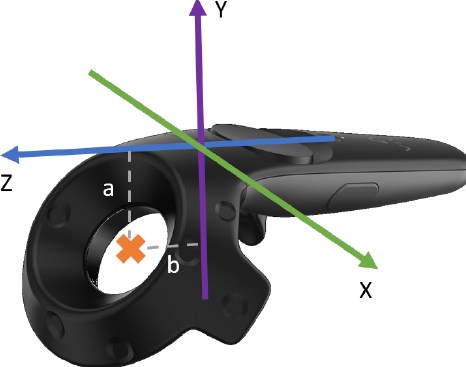
Figure 5. Coordinate